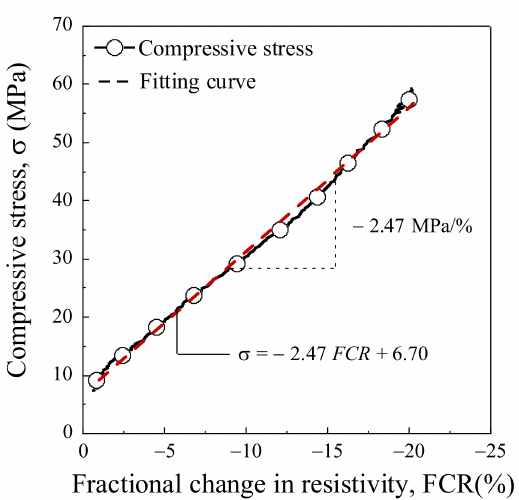
Figure 1. The correlation between the electrical resistivity response and the compressive stress of the smart concrete anchorage using smart